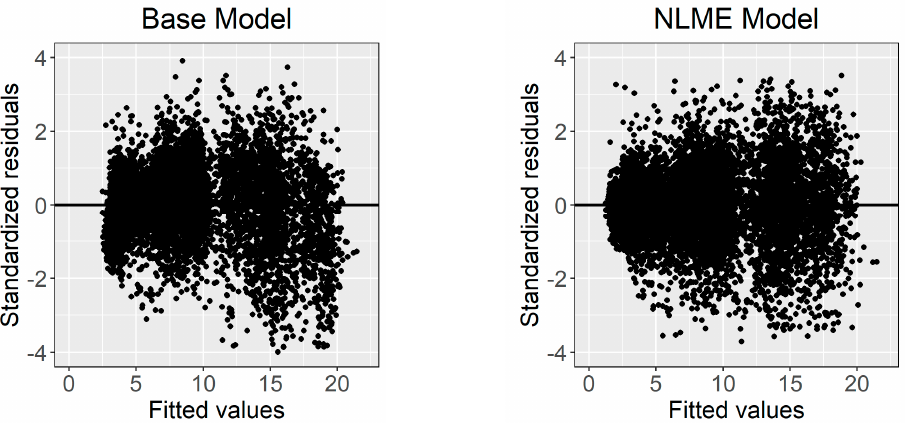
Figure 3. The standardized residuals distribution of the base model and calibrated NLME model.